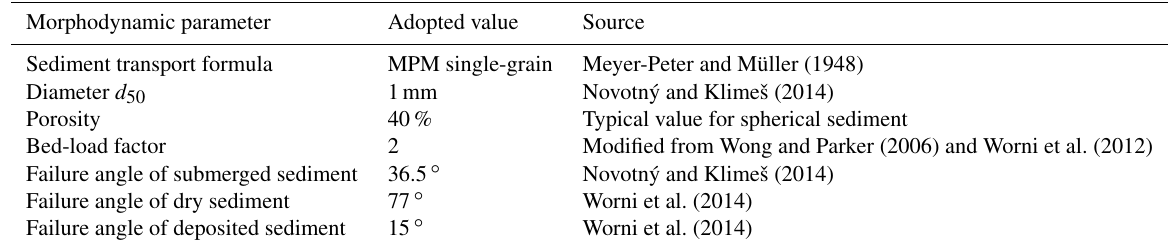
Table 1. Main parameters defining the soil matrix used in BASEMENT simulations of the Lake Palcacocha moraine. Morphodynamic